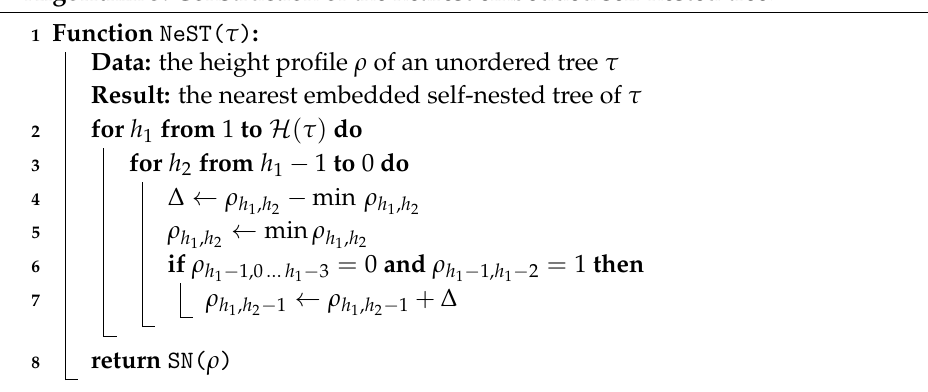
Algorithm 3: Construction of the nearest embedded self-nested